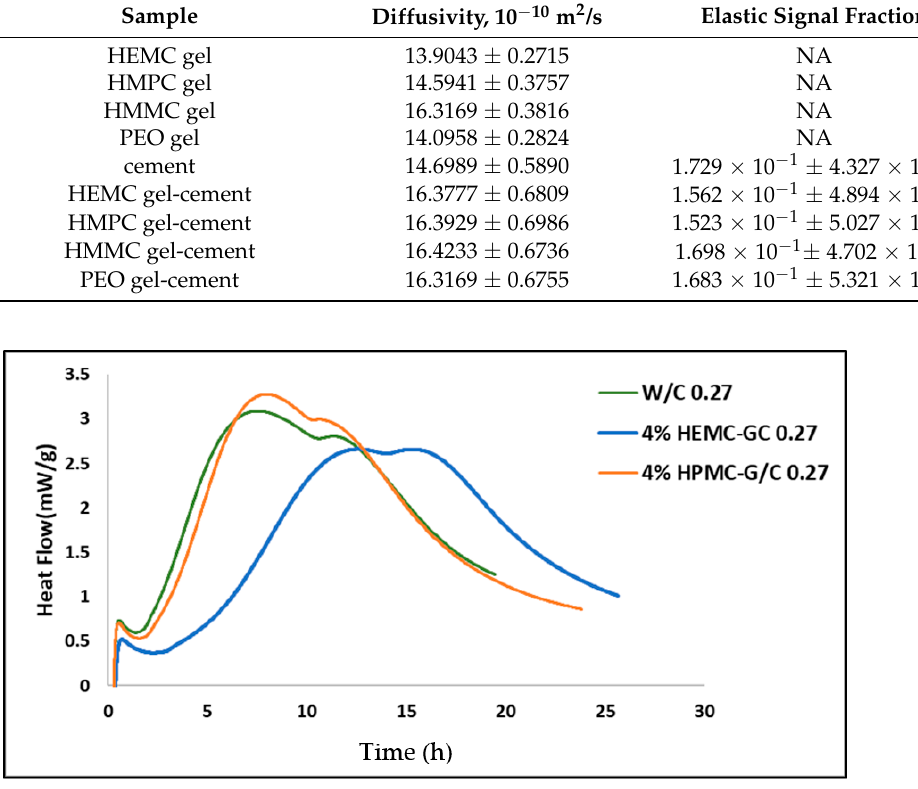
Figure 11. Hydration Calorimetry results for neat cement and gel-cement pastes containing 4 mass % HEMC and HEMC at a gel/cement ratio of 0.27. Table 1. Diffusion coefficients obtained from fit of the HWHM for DQ 2 + offset.